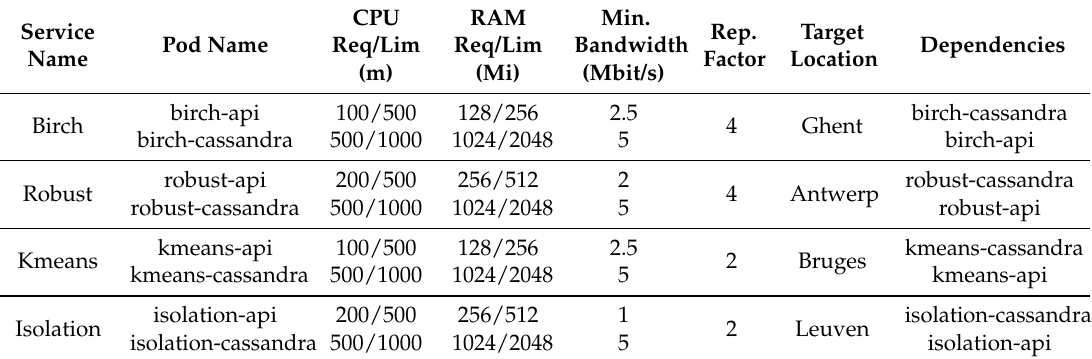
Table 4. Deployment properties of each service.